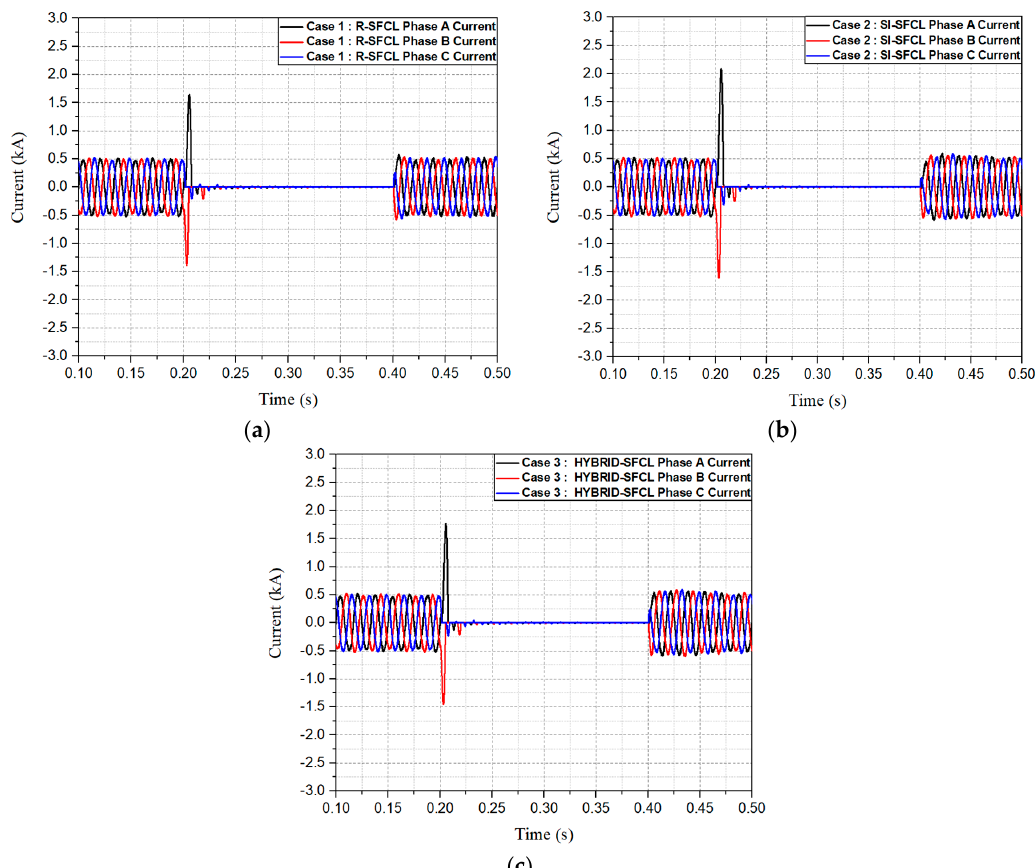
Figure 16. The transient current waveforms of the AC system according to the protection scheme: ( a ) Case 1: Protection scheme (R-SFCL and HCB); ( b ) Case 2: Protection scheme (SI-SFCL and HCB); ( c ) Case 3: Protection scheme (Hybrid-SFCL and HCB).